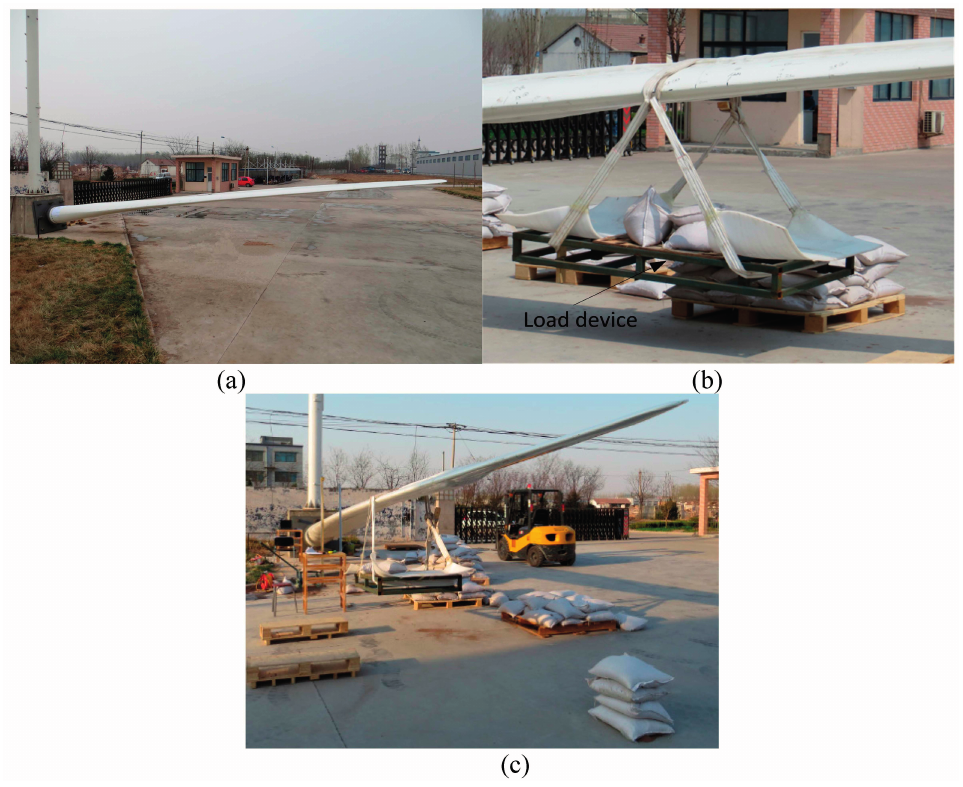
Figure 1. Experimental setup of the wind turbine blade. ( a ) Clamped wind turbine blade; ( b ) load device; and ( c ) global experimental setup.